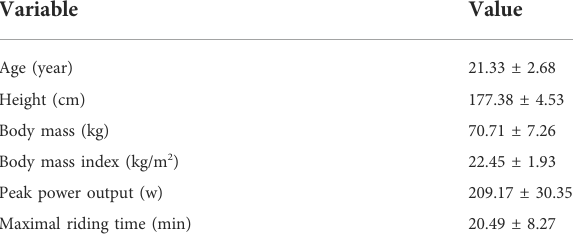
TABLE 2 Participants ’ physical characteristics (n = 24) (mean ±